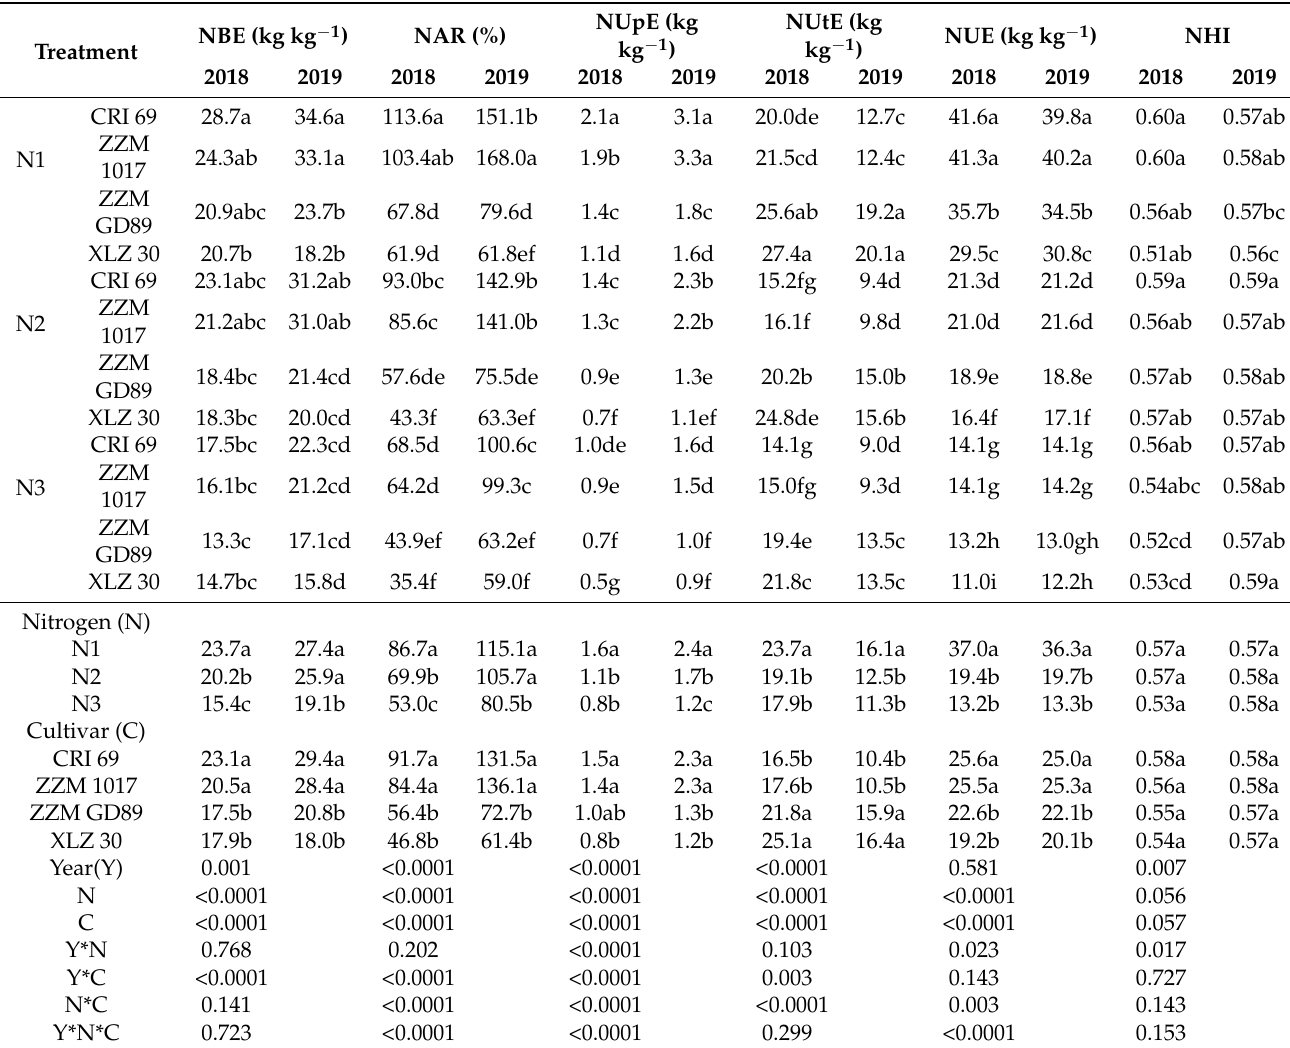
Table 4. N utilization-related traits of cotton cultivars under different N-supply conditions in 2018 and 2019